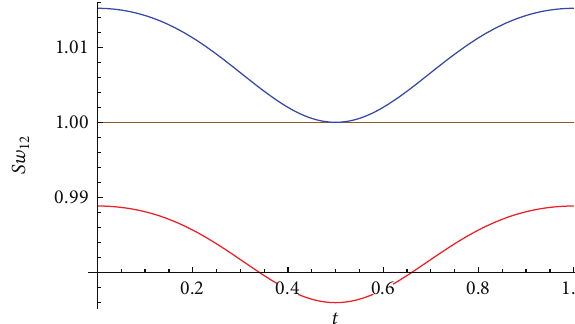
Figure 12: Stability function of the 2-cycle {𝑤 3 (𝛼),𝑤 4 (𝛼)} for 𝐶 3 and 𝐶 4 .